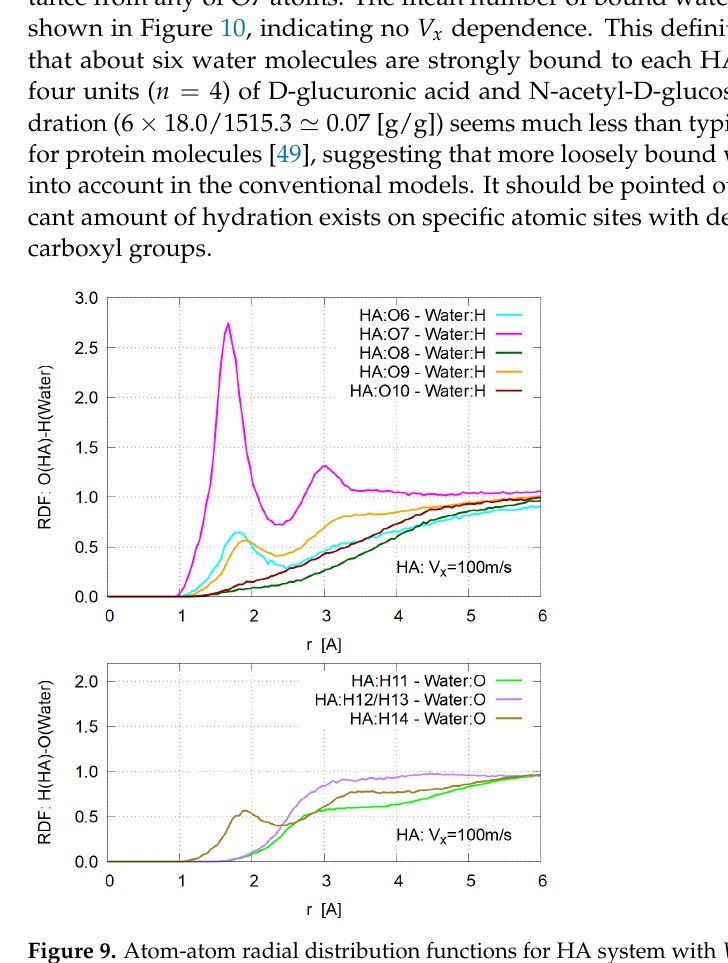
Figure 9. Atom-atom radial distribution functions for HA system with V x = 100m/s; ( Top ) Between oxygen atoms of HA and hydrogen of water, ( Bottom ) between hydrogen atoms of HA and oxygen of